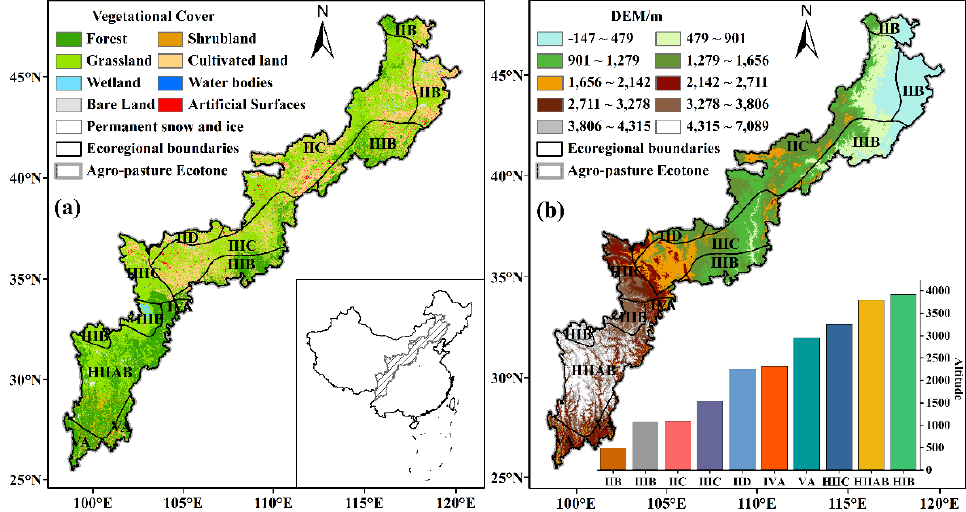
Figure 1. Distribution of the vegetation ( a ) and its topographic features ( b ) in the study